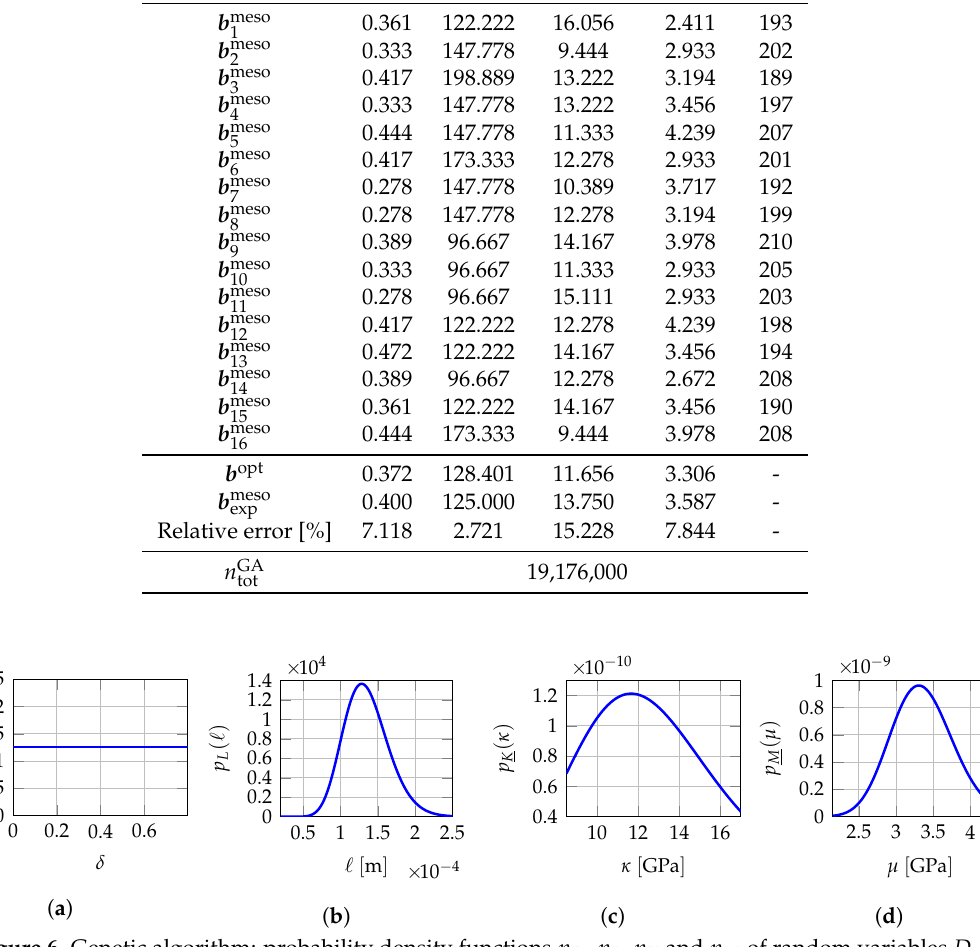
Figure 6. Genetic algorithm: probability density functions p D , p L , p K and p M of random variables D , L , K and M , respectively. ( a ) p D ( δ ) ; ( b ) p L ( (cid:96) ) ; ( c ) p K ( κ ) ; ( d ) p M ( µ )